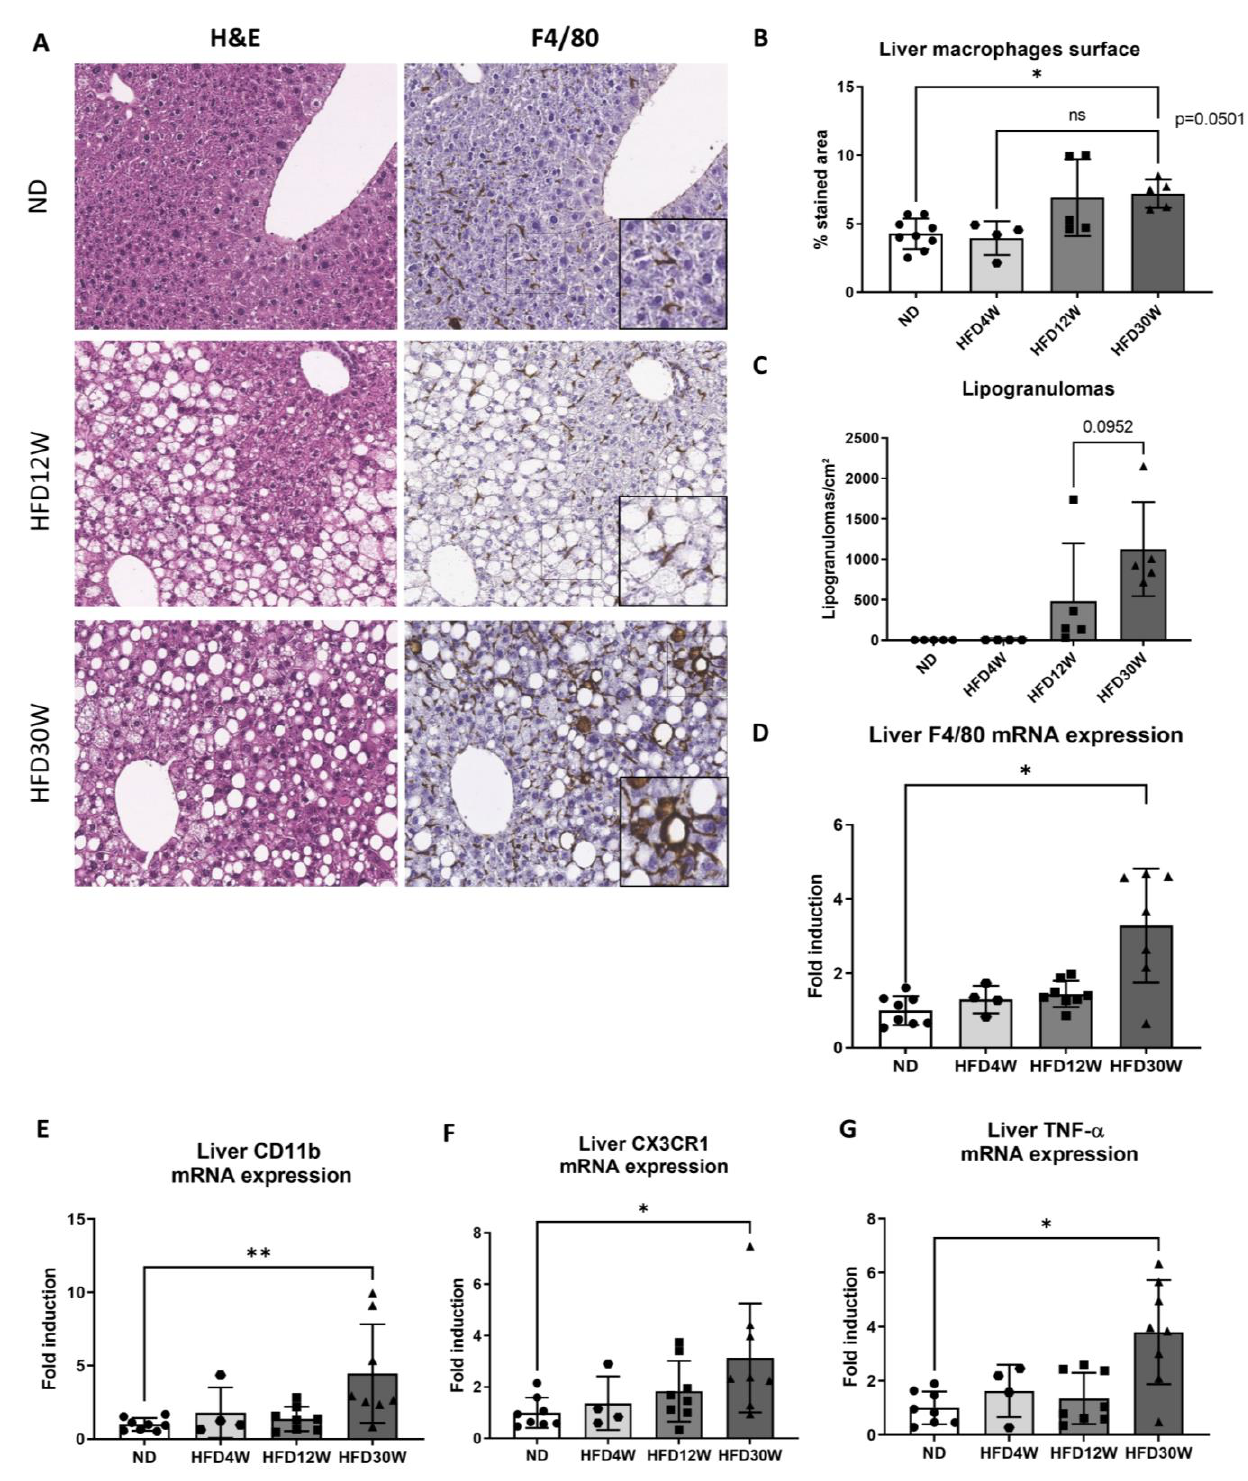
Figure 2. Foz − / − mice show activation of liver macrophages with the appearance of crown-like structures. Liver haematoxylin and eosin staining (H&E) and F4/80 macrophage marker in mice fed a normal diet (ND) or a high fat diet for 12 (HFD12W) or 30 weeks (HFD30W). The insets in the image show enlargements centred on the macrophages ( A ). Quantification of liver positive F4/80 macrophage surface on liver slides ( B ) and of crown-like structures or lipogranulomas ( C ). Liver mRNA expression of F4/80 ( D ), CD11b ( E ), CX3C chemokine receptor 1 (CX3CR1) ( F ), and tumor necrosis factor alpha (TNF- α ) ( G ). n = 4 – 8/group. * p < 0.05, ** p < 0.01.